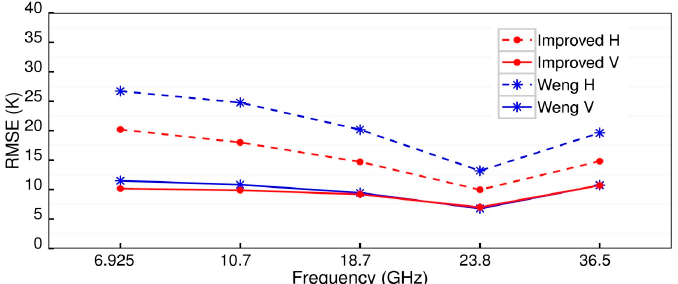
Figure 8. Comparison of the RMSEs between the observed and simulated brightness temperatures (in K ) using the Weng and the parameterized soil surface emissivity models for vertical ( V ) polarization and horizontal ( H ) polarization. Table 6. Percentage of the simulated brightness temperature errors against the satellite measurements between − 10 and 10 K using the Weng and parameterized soil-surface emissivity models ( V -pol: vertical polarization and H -pol: horizontal polarization).